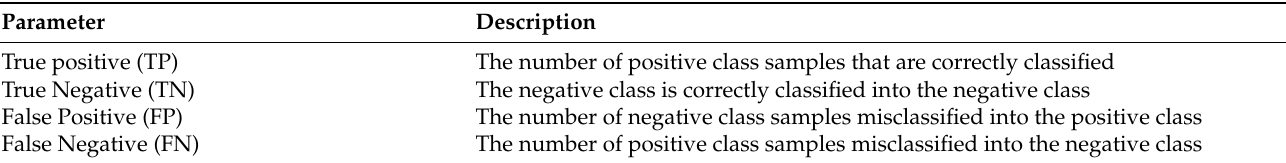
Table 4. Performance metric